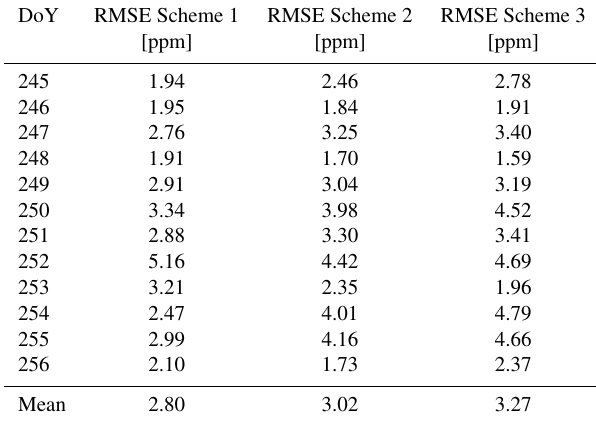
Table 1. RMSE of wet refractivity profile for different schemes dur- ing study period at first epoch